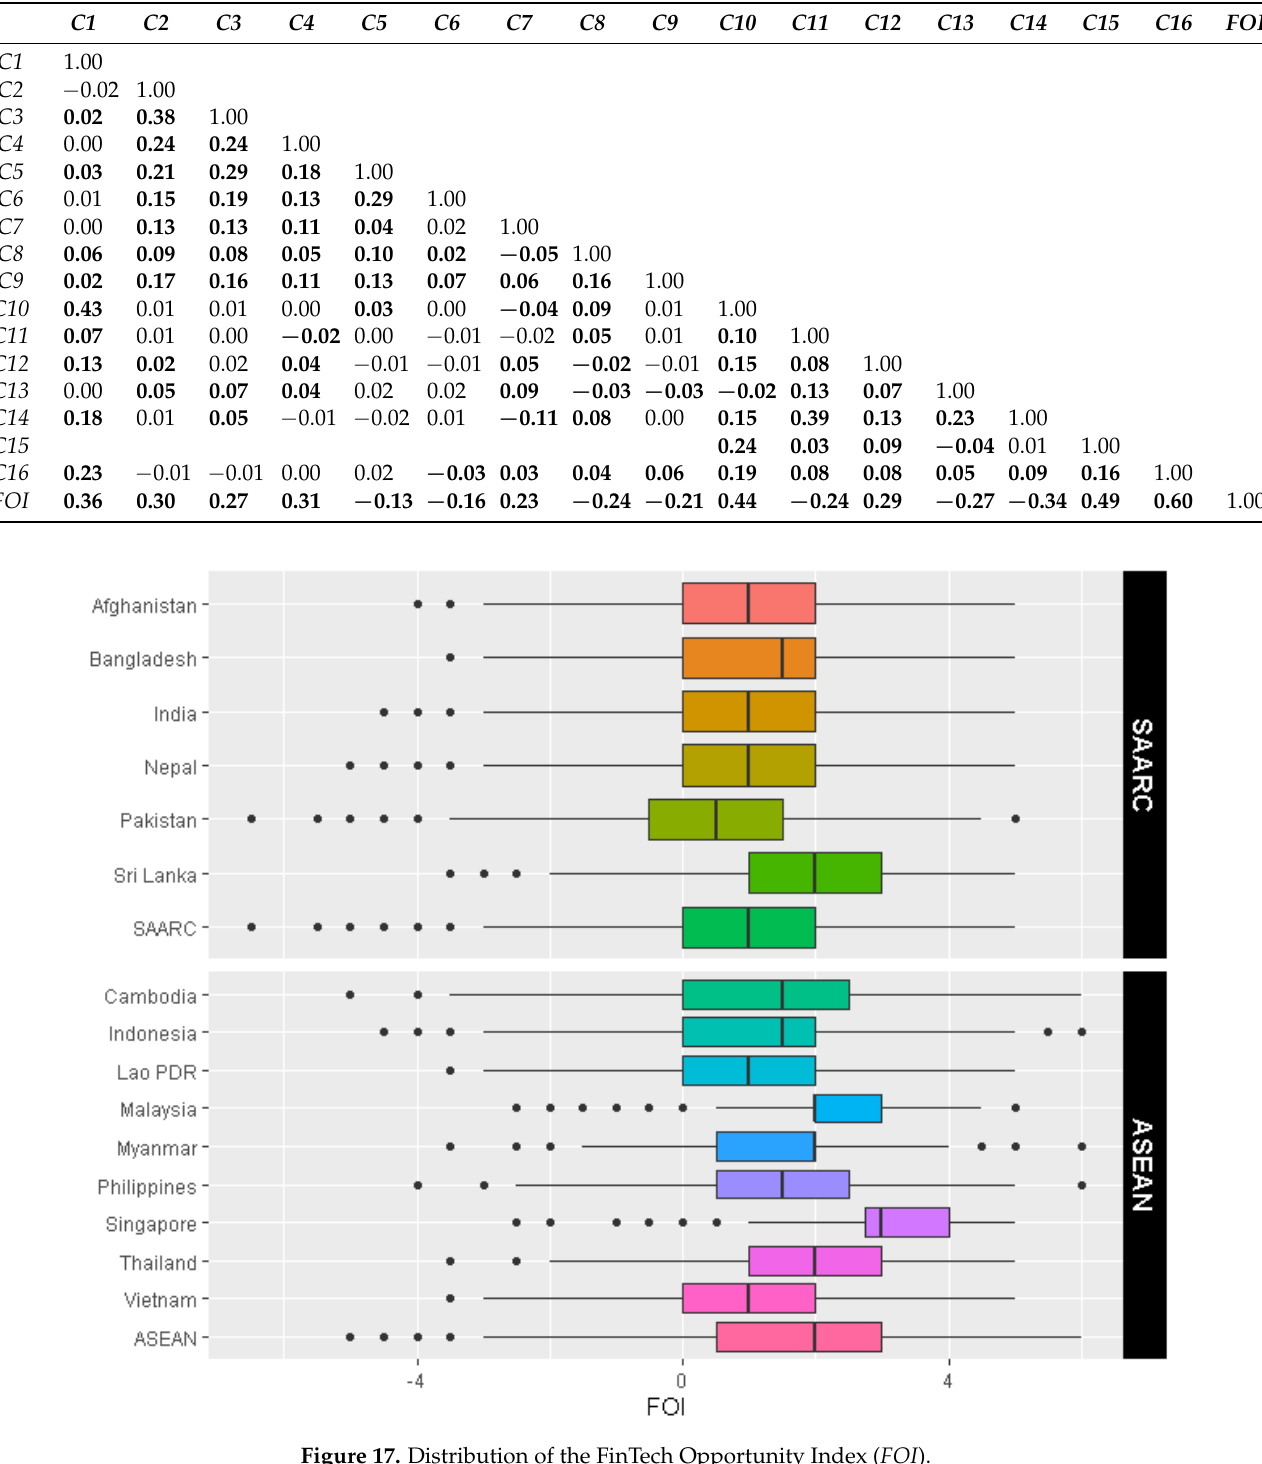
Table 4. Correlation matrix between criterion variables and the FOI . The bolded values are statistically significant at 95% confidence level.